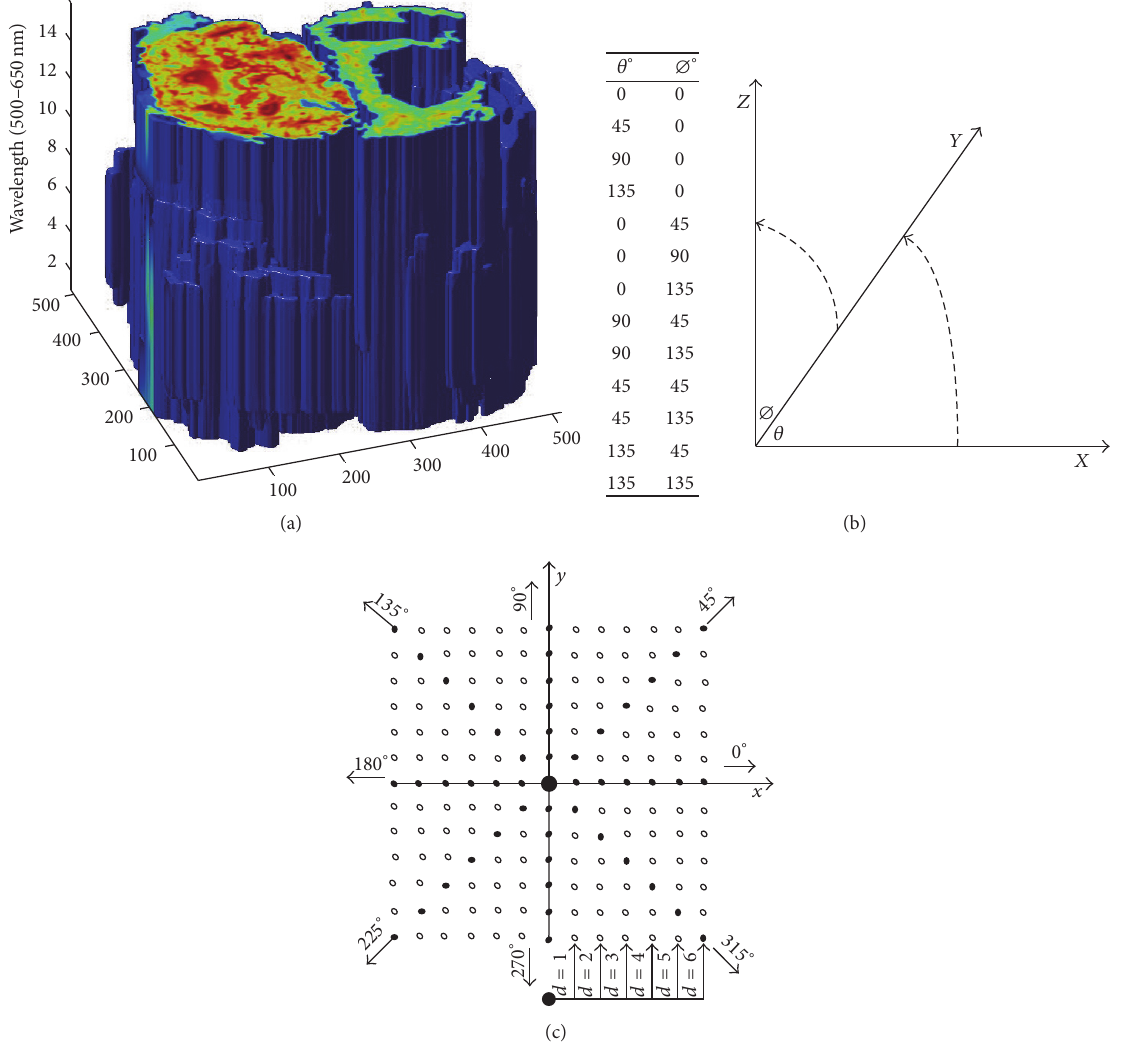
Figure 2: Volume data of multispectral bioimages are shown above. (a) Segmented multispectral gray scale images of carcinoma are analyzed pixel by pixel. In (b), 13 directions controlled by two angles ( 𝜃 ∘ , Ø ∘ ), where 𝑥 and 𝑦 are the image coordinates and 𝑧 is the wavelength range of 500–650 nm. (c) A computation map of GLCM shows the distance with direction in